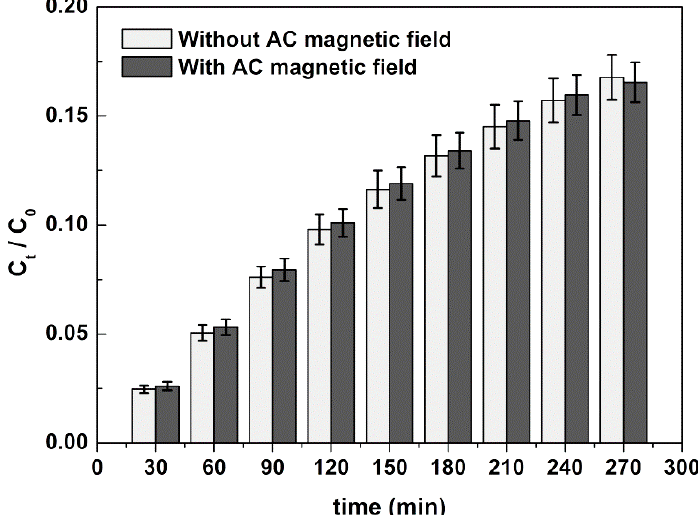
Figure 9. Drug release profile of curcumin from DPPC SMLs with and without the application of an alternating magnetic field. Experimental data is presented as average value ± standard deviation of three independent assays.